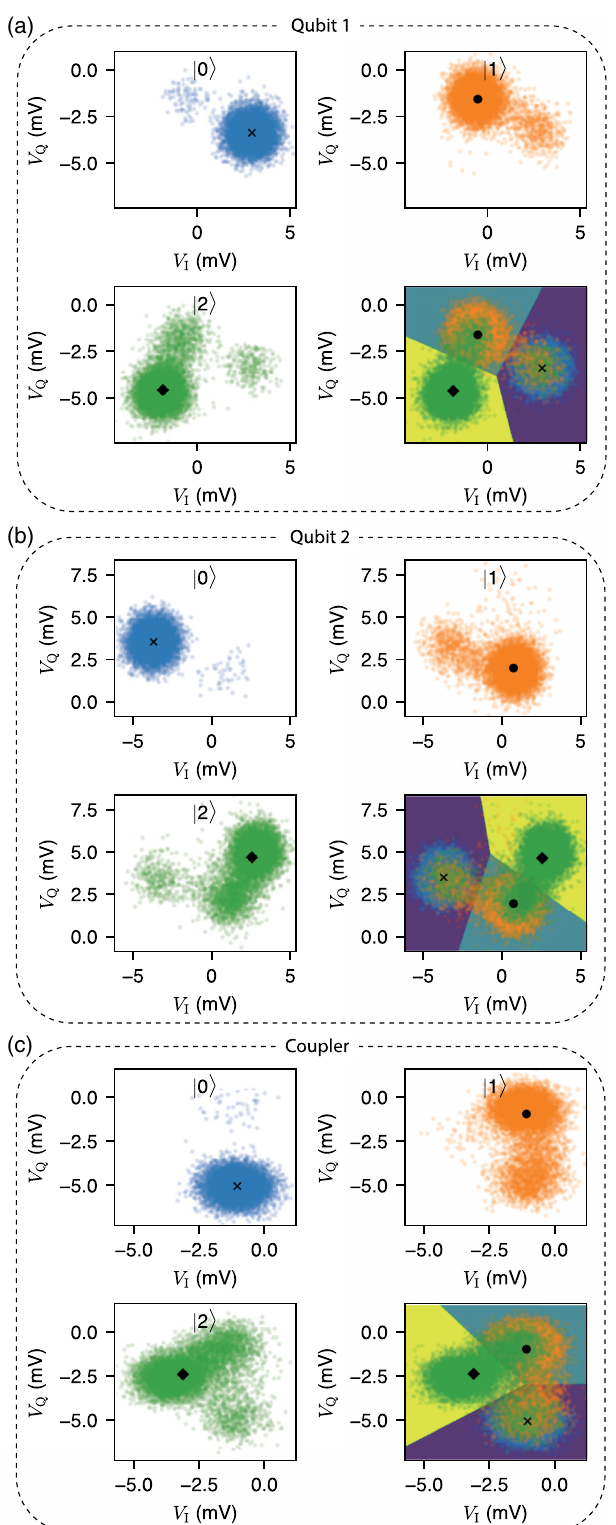
FIG. 13. Single-shot measurements in the I - Q plane for the qubits (a),(b) and the coupler (c). For the same color points, we repetitively prepare at the corresponding state and measure the I - Q outcomes (number of repetitions, 10 000). Black markers denote the median points.